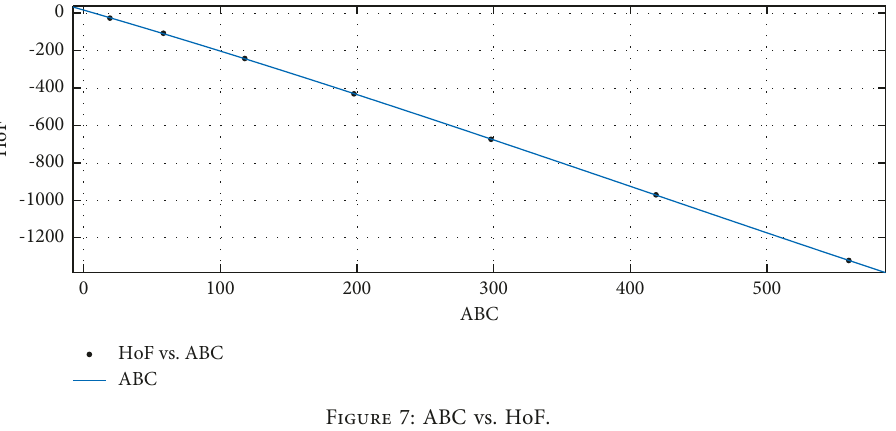
Figure 6: R (− 1/2 ) vs. HoF.